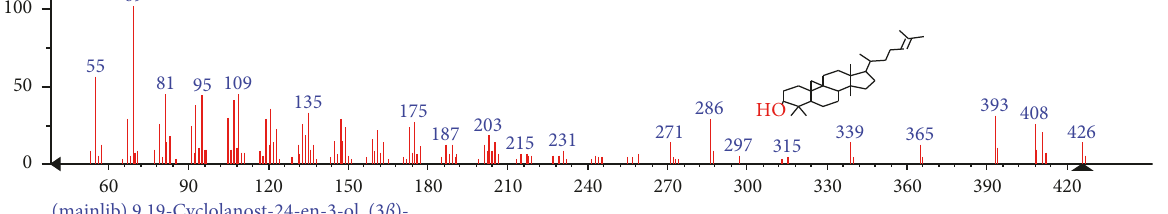
Figure 64: Mass spectrum of compound 9,19-cyclolanost-24-en-3-ol, (3 β )- of whole plant hexane fraction of Achillea wilhelmsii